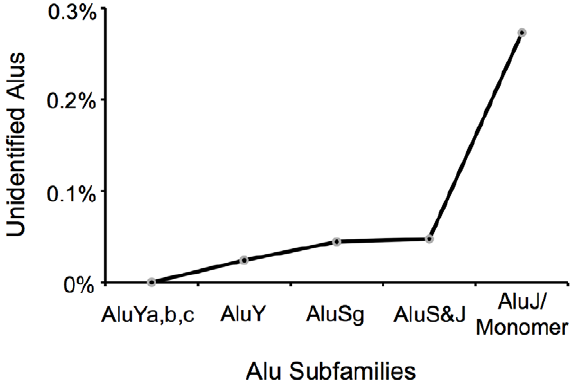
Figure 4. Percentage of Alu elements in different Alu subfamilies not annotated by P-clouds analysis. Displayed are elements for which no portion was annotated. The relative age of Alu subfamilies increases from left to right.